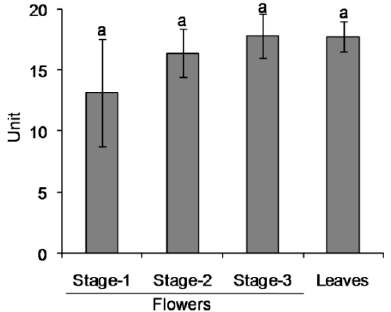
Figure 3. Evaluation of activities of crude enzymes involved in the pathway leading from acetophenone to 1PE from tea flowers and tea leaves. Data are expressed as Mean ± S.D. ( n = 3). Three groups of tea leaves or tea flowers were used for analysis. Each group contained a mixture of 10 tea flowers or 10 tea leaves (containing one bud and three leaves). Means with same letters are no significant differences ( p > 0.05). Here the unit represented enzyme specific activity.